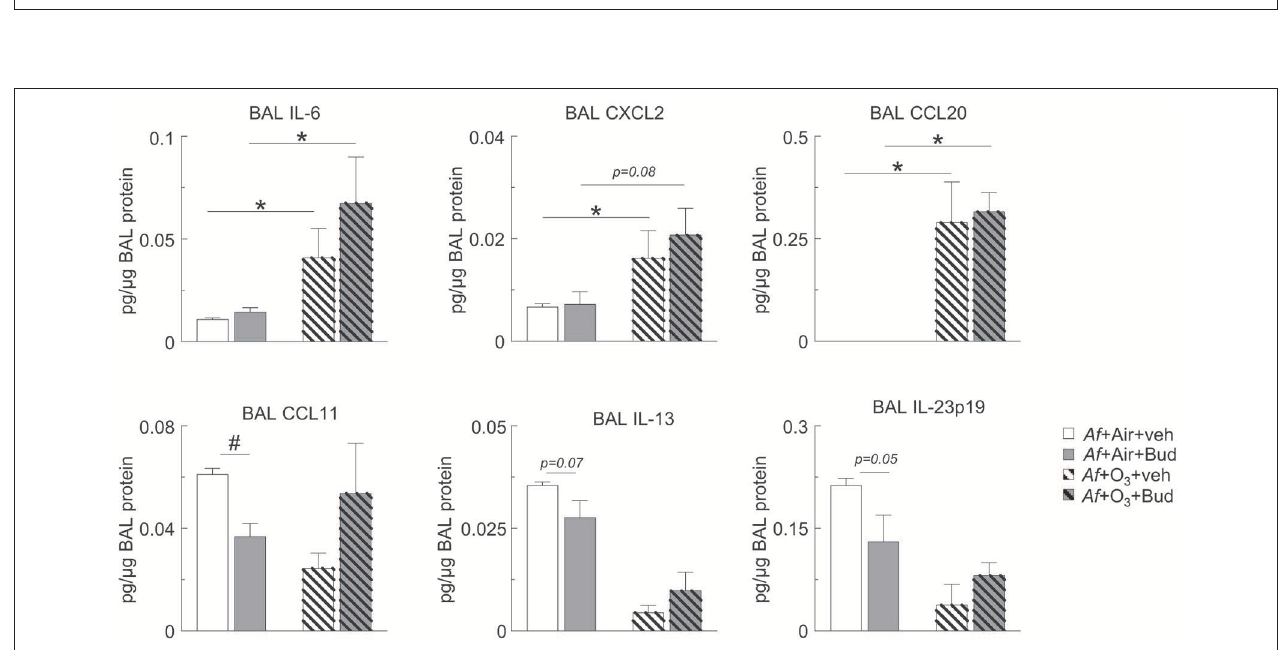
FIGURE 4 | O 3 upregulated BAL IL-6, CXCL2, and CCL20 in a budesonide-resistant manner and reversed the inhibitory effects of budesonide on CCL11, IL-13, and IL-23 expression in mice sensitized and challenged with Af. Cell-free BAL supernatant was assessed for the indicated cytokines and chemokines by a R&D mouse magnetic Luminex Assay (pg cytokine/ µ g BAL protein). Mean ± SEM of n = 3; * p < 0.05, # p < 0.05 Student’s t -test [vehicle vs. budesonide (#) or air vs. O 3 (*)].